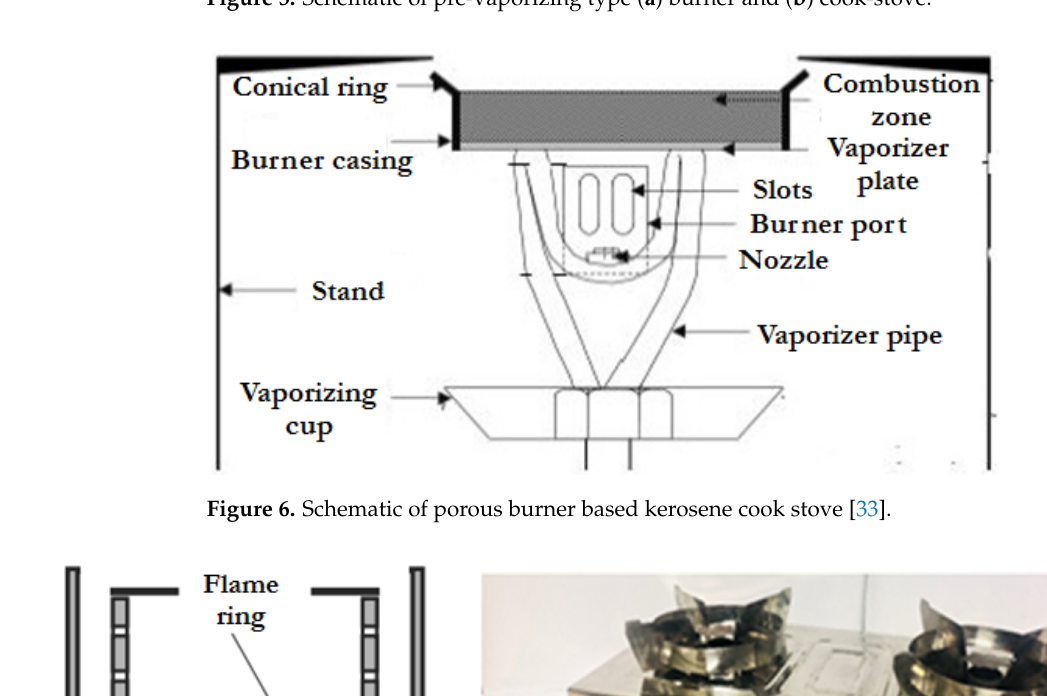
Figure 5. Schematic of pre-vaporizing type ( a ) burner and ( b ) cook-stove.